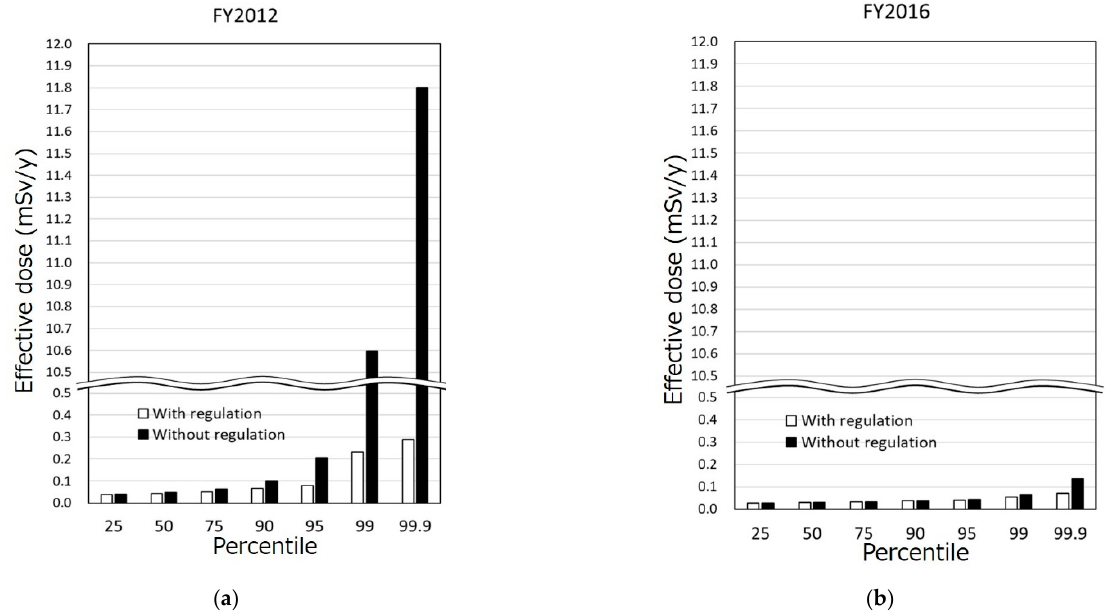
Figure 4. Differences in the radiation dose throughout Japan with or without regulation in each percentile in ( a ) FY2012 and ( b ) FY2016.